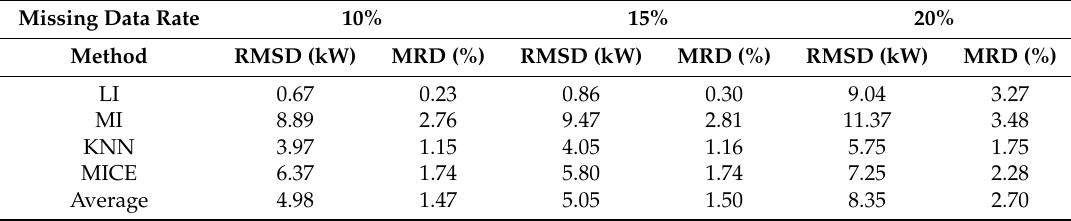
Table 6. Deviation of missing data imputation from the PV forecasting model with test data in March. Missing Data Rate